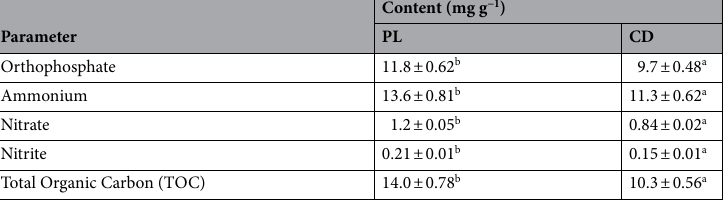
Table 2. Characteristics of poultry litter (PL) and cow dung (CD). Values were calculated as the mean (± SE) of three independent observations, i.e., n = 3. Significant differences among the values (P < 0.05, DMRT) within a row are designated using different alphabetic